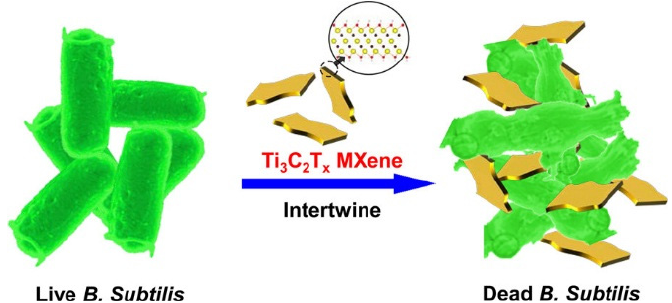
Figure 11. Schematic depiction of antibacterial activity of Ti 3 C 2 T x MXene [3]. Rasool et al. tested the antibacterial efficacy of three materials (Ti 3 AlC 2 (MAX), as- produced ML-MXene and delaminated Ti 3 C 2 T x nanosheets) against E. coli and B. subtilis